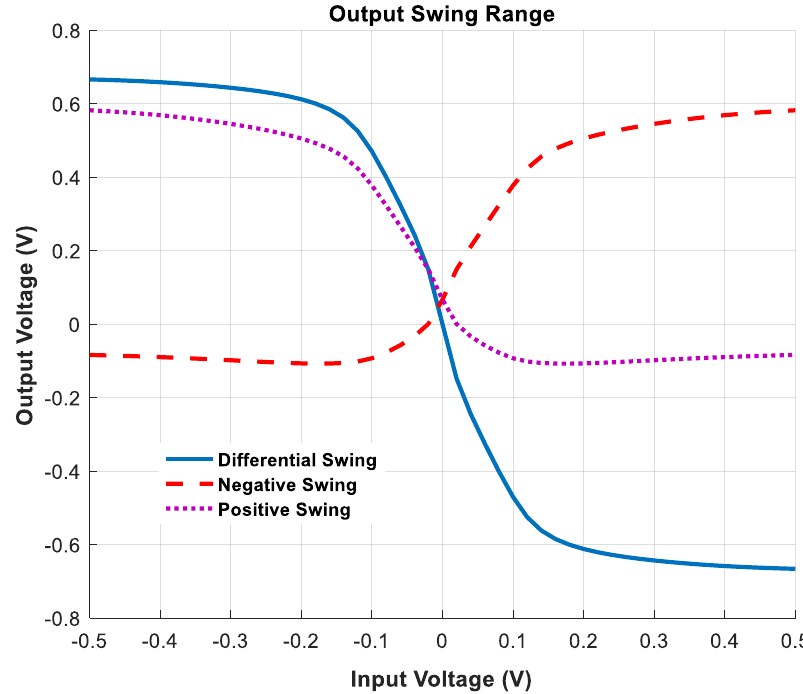
Figure 13. The output swing of the proposed inverter-based amplifier.